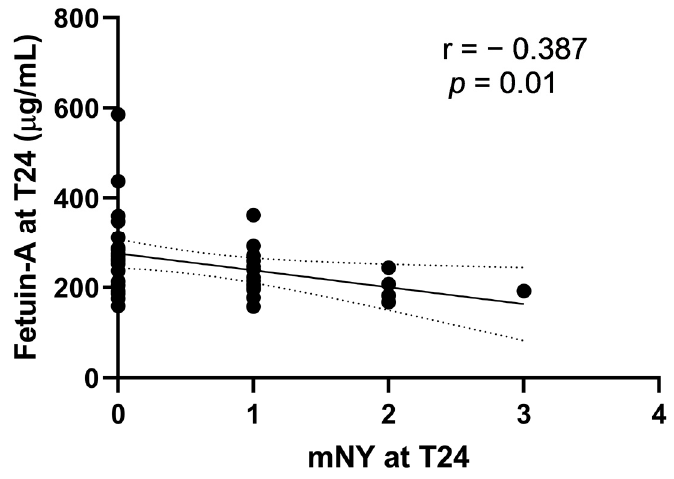
Figure 3. Scatterplot: Association of Fetuin-A at T24 and of mNY at T24. Again, only fetuin-A levels at T24 were significantly associated with mNY at T24 ( β − 0.3, p < 0.001). 2.6. Baseline Predictors of Radiographic Damage in the SIJs (mNY T24) (Univariate Analysis and Multivariate Linear